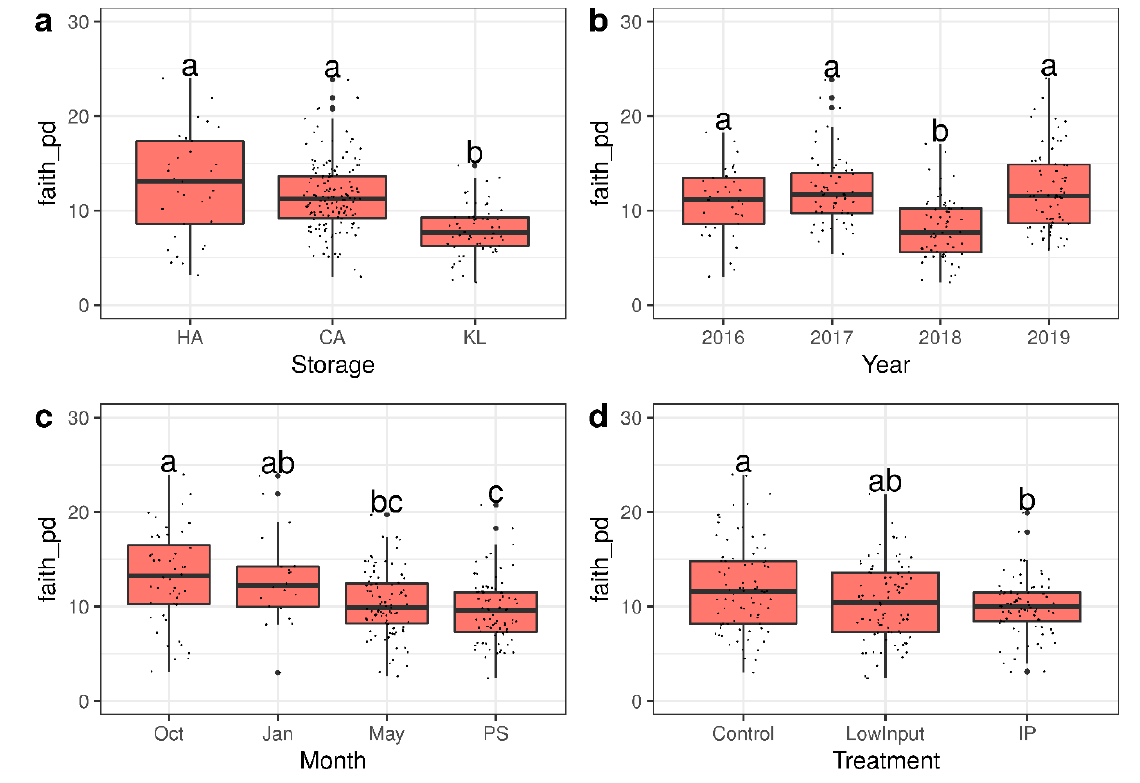
Figure 3. Alpha diversity measured as Faith’s PD values of the fungal microbiome: ( a ) Storage condition; ( b ) growing year; ( c ) storage duration; ( d ) plant protection treatment. Letters denote significance as calculated in Kruskal–Wallis tests with Fisher post hoc tests .